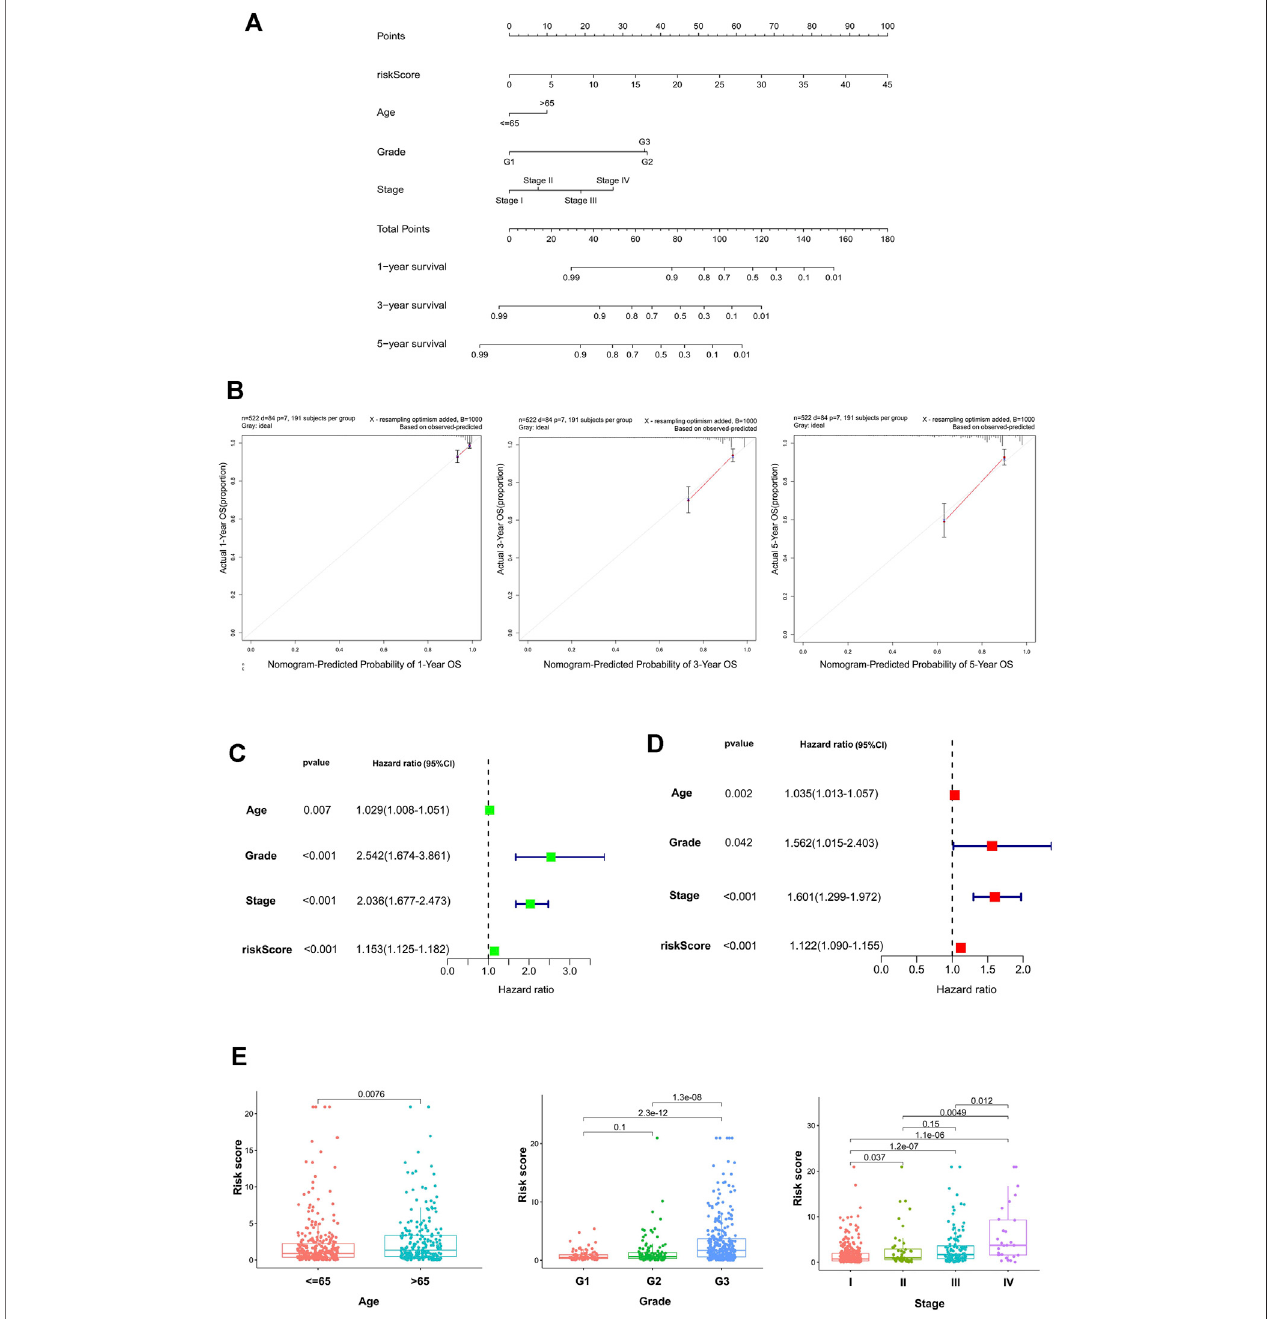
FIGURE3| Theestablishmentand validation ofthenomogram. (A) Thenomogramconsisted ofage,gender, FIGOstage, and riskscore,and wasused topredict the 1-, 3-, and 5-year survival probability of EC patients. (B) Calibration plots of the AS-clinical nomogram are in agreement between the nomogram-predicted and observed1-,3-,and 5-yearoutcomes oftheUCECcohort.Thenomogram-predicted survivalprobabilityisplottedonthe x -axis, andtheactualsurvivalisplottedonthe y -axis. The 45 ° dashed line represents the ideal performance. The red lines represent the actual performancesof the model, and the fi gures from left to right depict the 1-, 3-, and 5-year results. Univariate analysis (C) and multivariate analysis (D) of risk scores and clinical characteristics that were simultaneously associated with OS. (E) Differences in the risk score in terms of age, grade, and FIGO stage groups. The bottom and top of the boxes are the 25th and 75th percentiles (interquartile range).